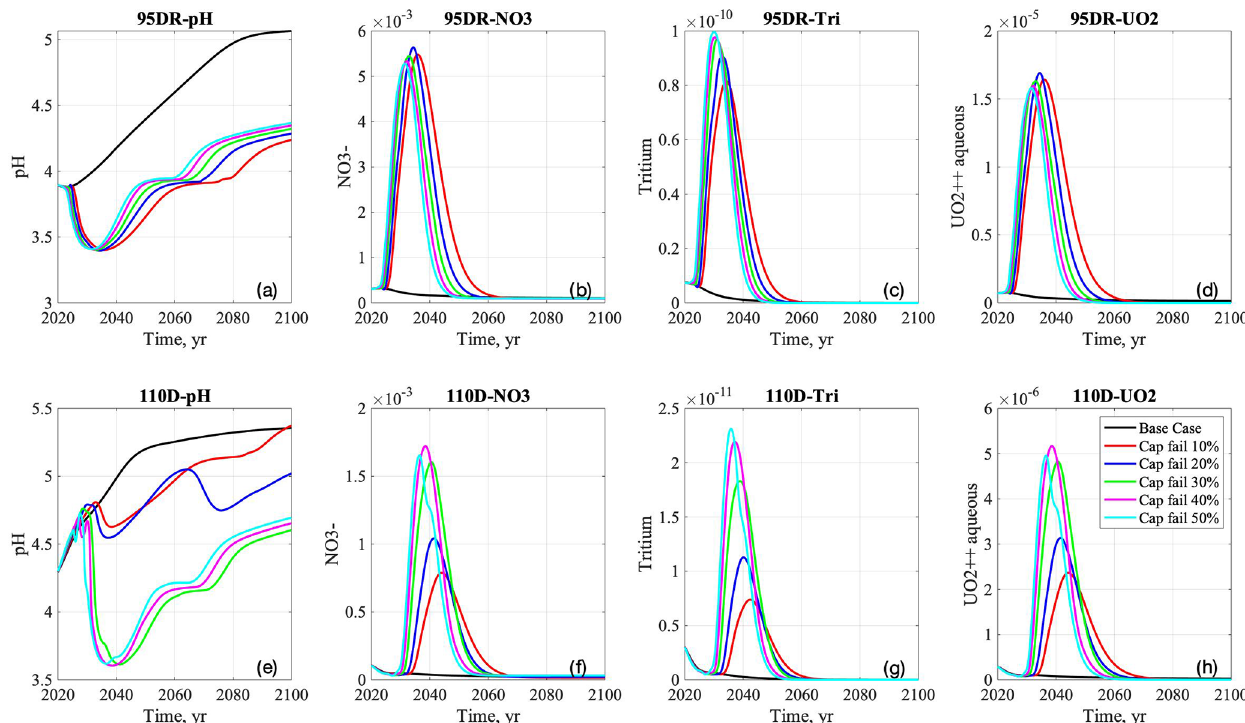
Figure 10. Breakthrough curves of pH, aqueous uranium, tritium, and nitrate at the source-zone well (a–d) and downgradient well (e–h) in the base case and cap-failure scenarios from 2020 to